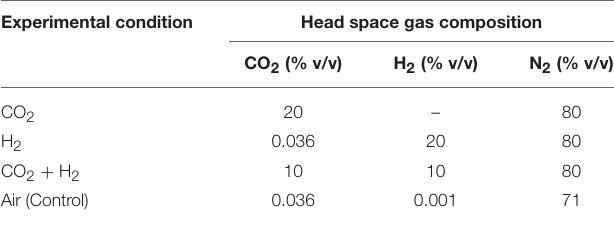
TABLE 1 | Experimental setups with the operational parameters in batch